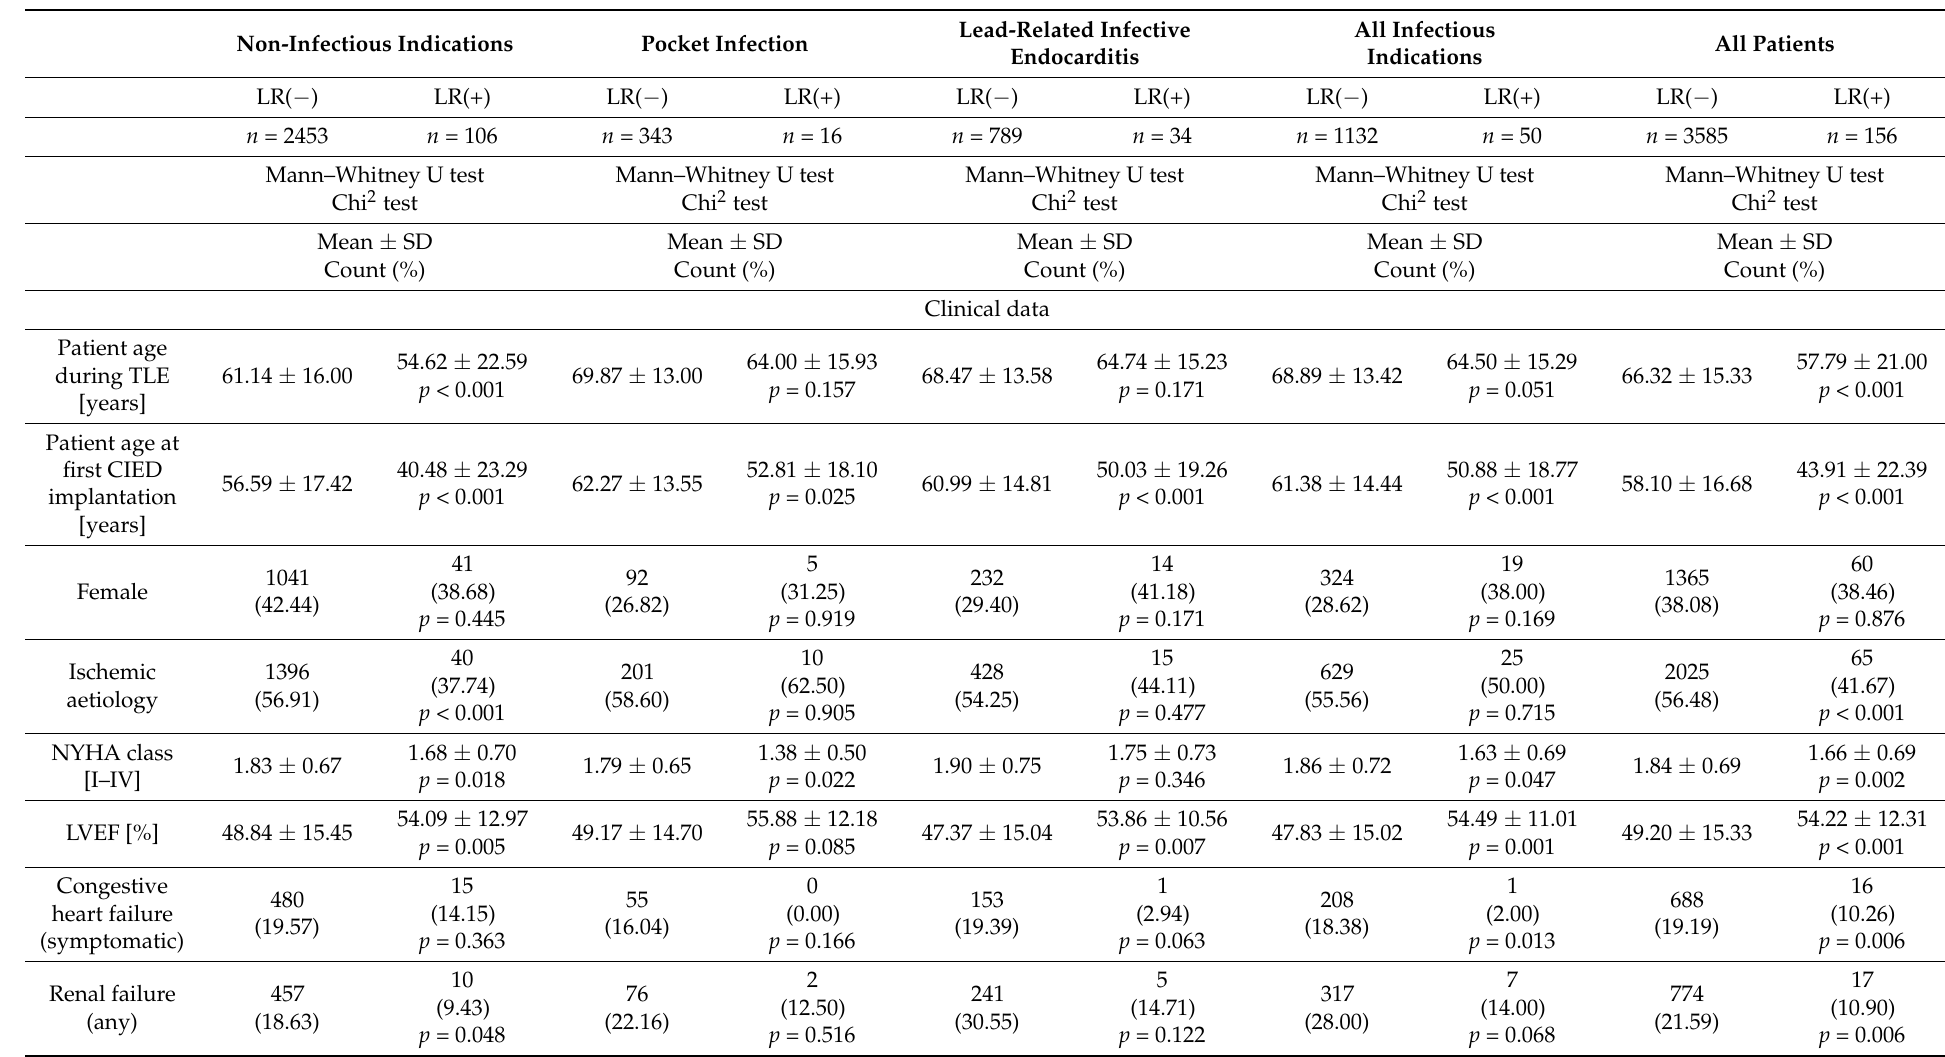
Table 1. Clinical data, indications for lead extraction and pathogen type in infectious patients. Non-Infectious Indications Pocket Infection